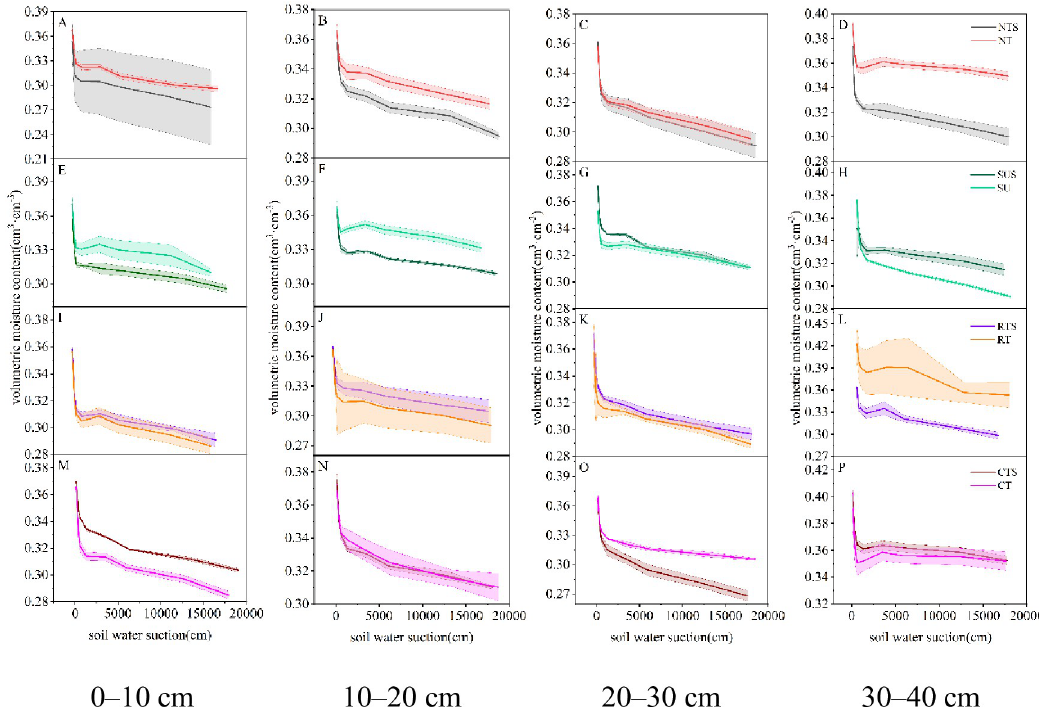
Fig 5. Effect of straw return on the SMCC of each tillage cultivation in each soil